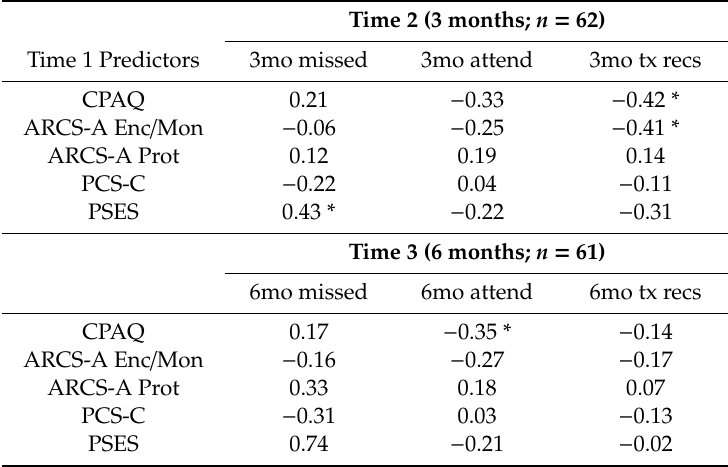
Table 2. Multiple Regression Analyses with Time 1 Adolescent-Reported CPAQ, ARCS-A, PSC-C, and PSES Indices Predicting Time 2 and Time 3 Treatment Compliance Variables.